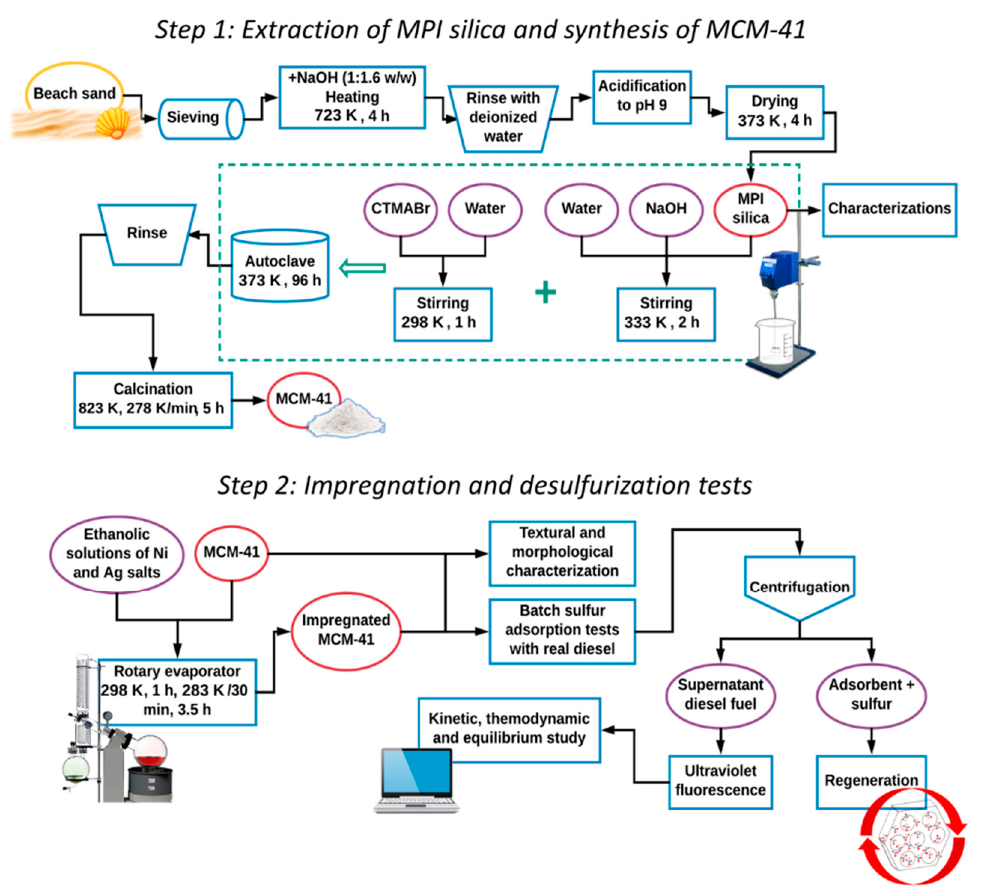
Scheme 1. Process flow diagram for the methodology used in this work.